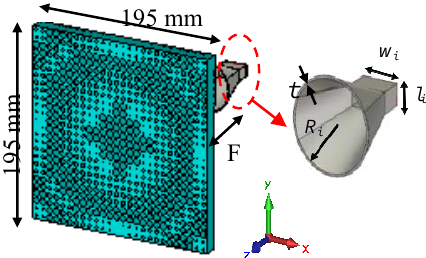
Figure 4: The 3-D detailed construction of the configuration 13×13 NF focused